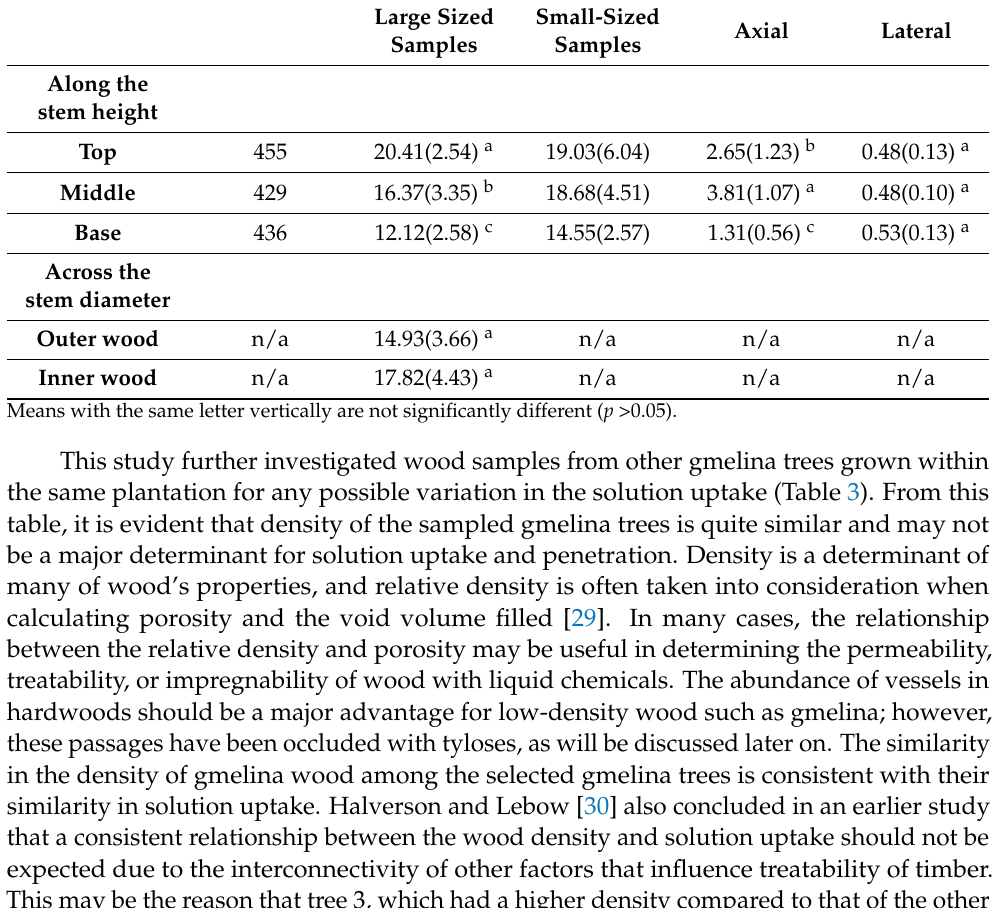
Table 2. Mean values for solution uptake and penetration of colored liquid into Gmelina arborea wood (standard deviation in parenthesis) along the stem height and across stem diameter. Density Solution Uptake Penetration Depth kgm − 3 (%) (mm) Large Sized Small-Sized Axial Lateral Samples Samples Along the stem height Top